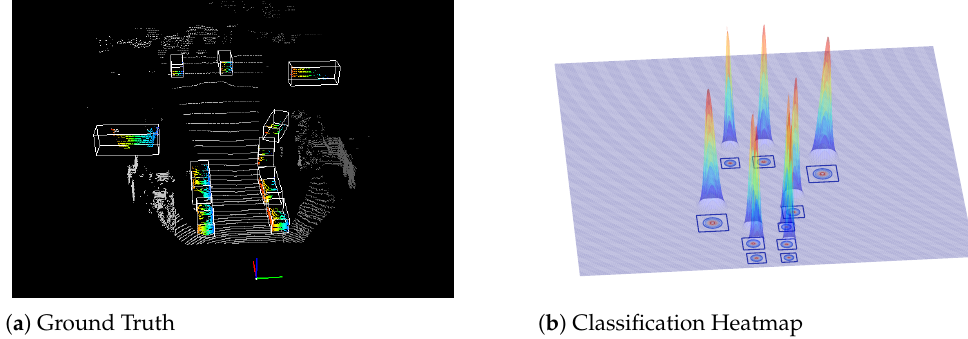
Figure 3. We generate classification heatmap labels ( b ) from a ground truth dataset ( a ). Labels are calculated via adaptive Gaussian